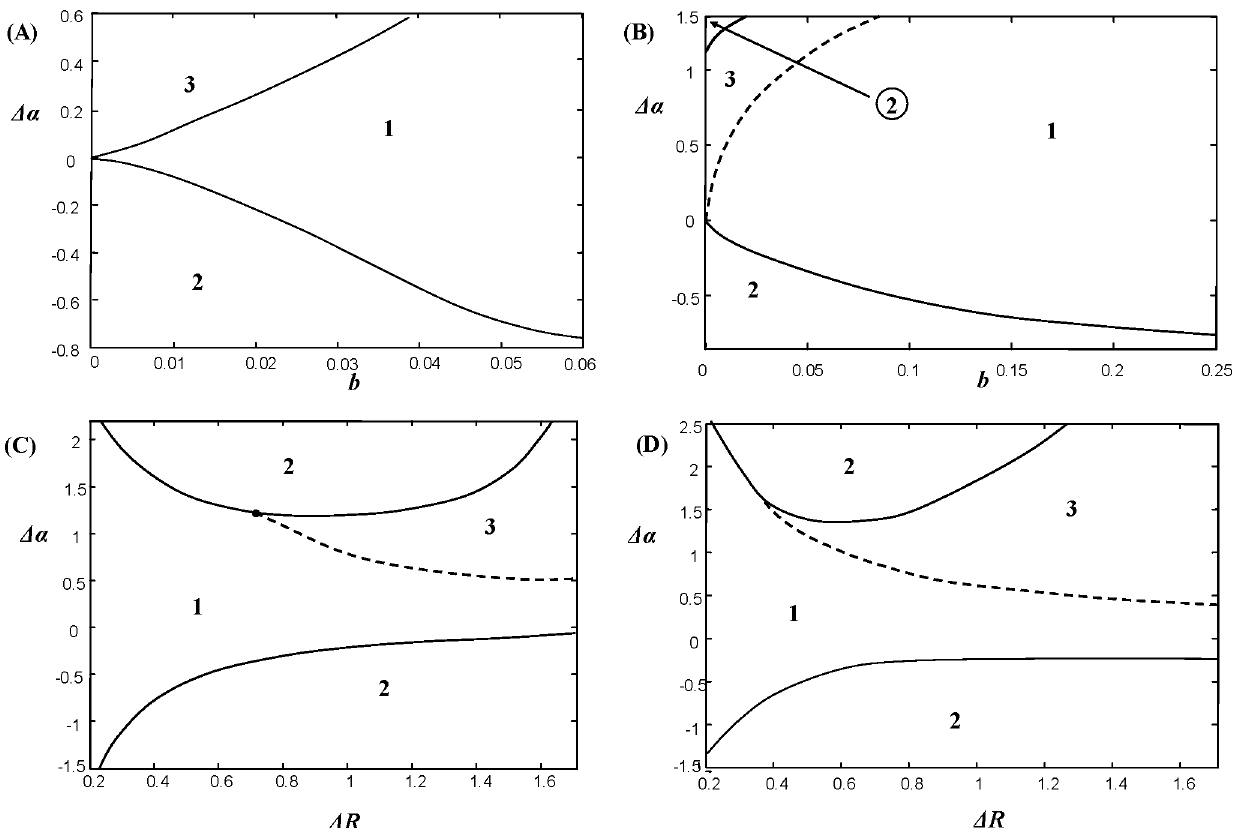
Figure 4. Bifurcation diagrams for predator-prey system (1)–(2) for the linear trade-off relation a ( R ) given by (6). Successful top-down control of the system is possible in domains 2 and 3 (the solutions are bounded) and impossible in domain 1. The meaning of the domains is explained in text. Diagrams (A), (B) are constructed for a large value of D ( D =5), which signifies that w R , ~ RR (cid:1) (cid:2) & const ; diagrams (C) and (D) are obtained for a smaller D ( D =0.3). In diagrams (C),(D) the parameter D R denotes the range of the growth rates D R=R 2 –R 1 ; we consider that ( R 2 + R 1 )/ 2= const =0.85 and b =0.015. The other model parameters are m= 0.1; h =0.5, a 0 =1.